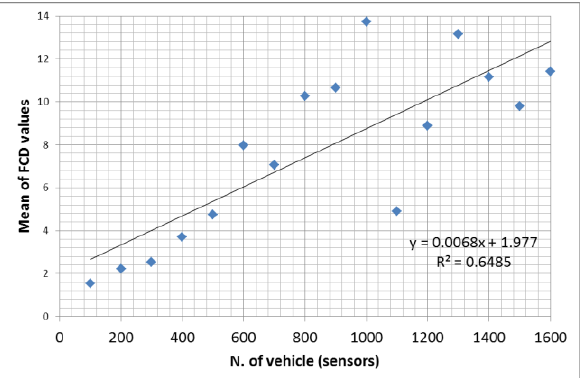
Figure 9. Mean value of FCD data plotted against vehicle transit categories acquired by